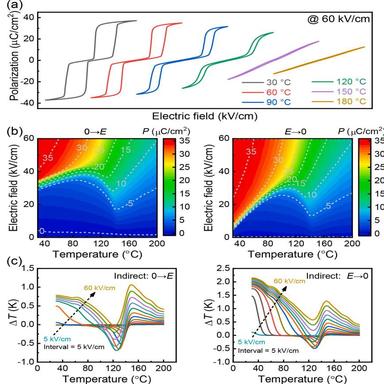
(a) P-E loops at different temperatures under 60 kV/cm. (b) The contour map of polarization intensity as a function of temperature and electric field. (c) EC temperature changes by indirect EC measurement using lower (0→E) and upper (E→0) branches of the P-E loops.